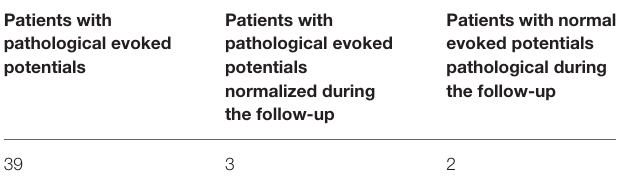
Patients with normal evoked potentials pathological during the